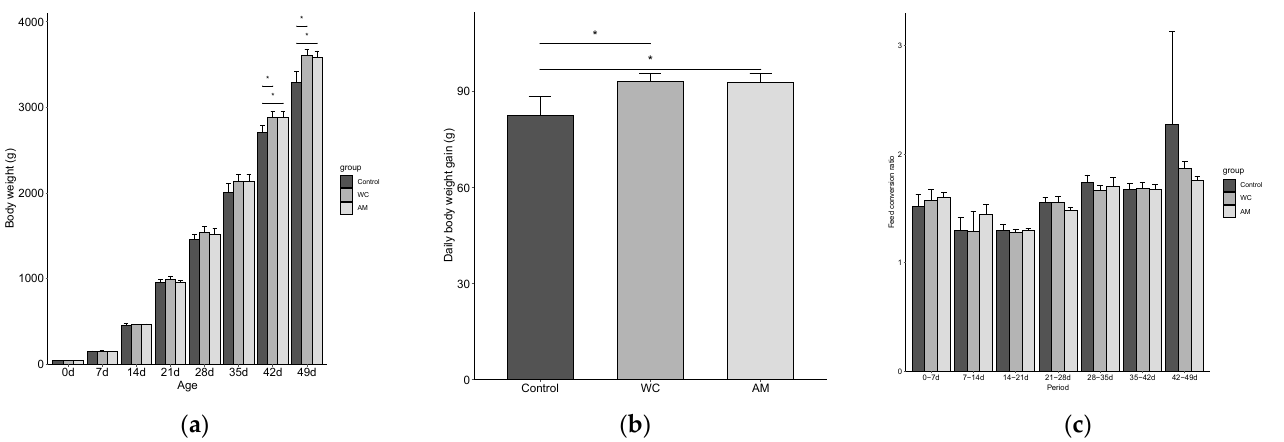
Figure 1. The production performance parameters of broilers, pre– (0 to 21 days of age) and post– (21 to 49 days of age) coccidial infection, in Experiment 2. ( a ) Mean body weights throughout the experiment. ( b ) Daily weight gains post-coccidial infection. ( c ) Feed conversion ratios throughout the experiment. Bars represent the means of data per pens and error bars represent the standard deviations ( n = 3). WC, supplementation with 3 × 10 5 CFU of Weizmannia coagulans strain SANK70258/g; AM, 75 ppm of sodium lasalocid-A in feed. Asterisks indicate the significant difference between groups ( p < 0.05).